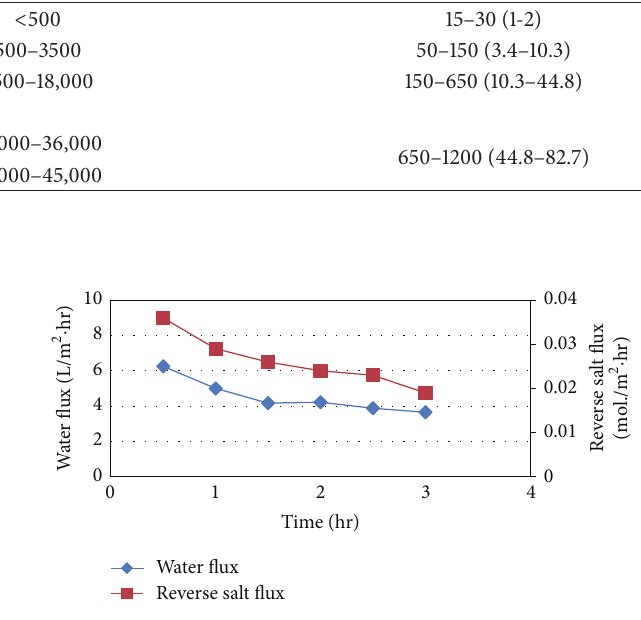
Figure 9: Water and reverse solute fluxes as a function of time (concentrated Ezz Steel treated wastewater from FO after 6hr + RO concentrate) (2nd stage of FO-batch process).